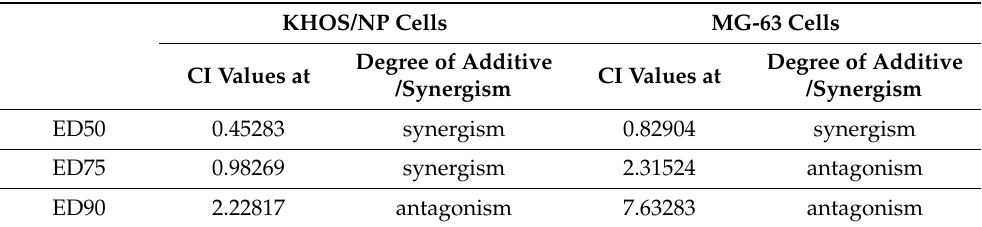
Table 1. Combination Index (CI) values of the interaction between expanded γδ T cells with DOX against osteosarcoma (OS) cells. KHOS/NP Cells MG-63 Cells Degree of Additive Degree of Additive CI Values at CI Values at /Synergism /Synergism ED50 0.45283 synergism 0.82904 0.98269 2.31524